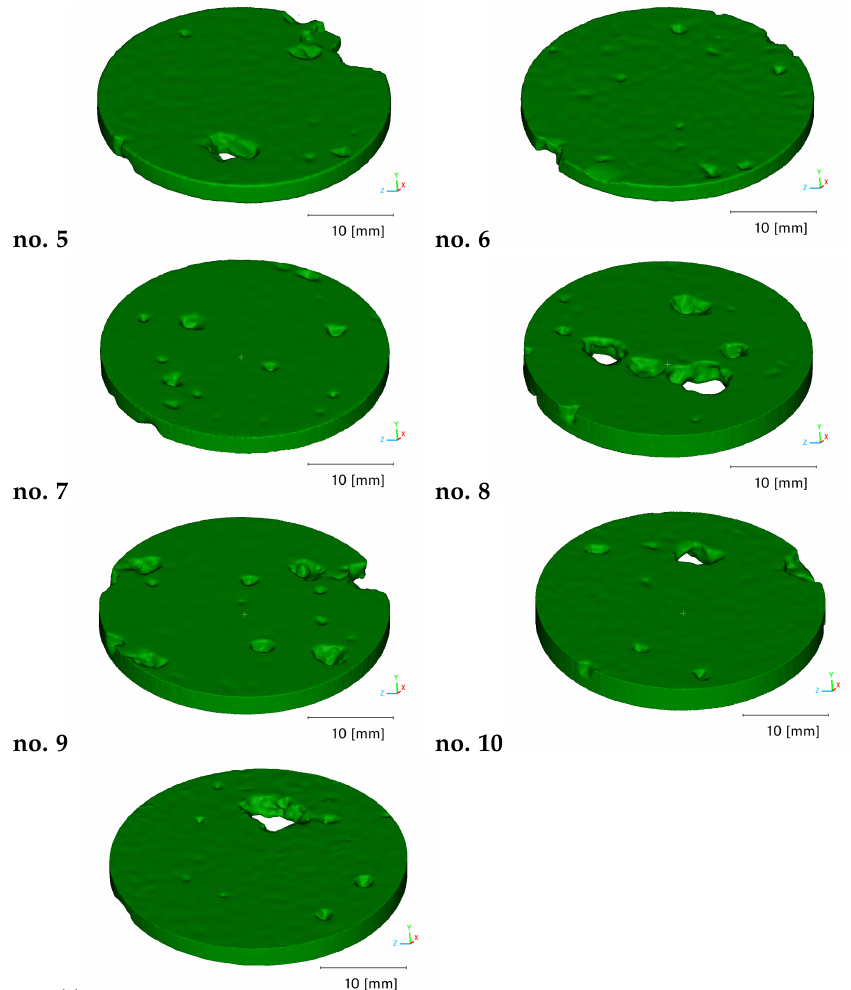
Figure 9. The 3D models of the individual slices of DK 402 sample.